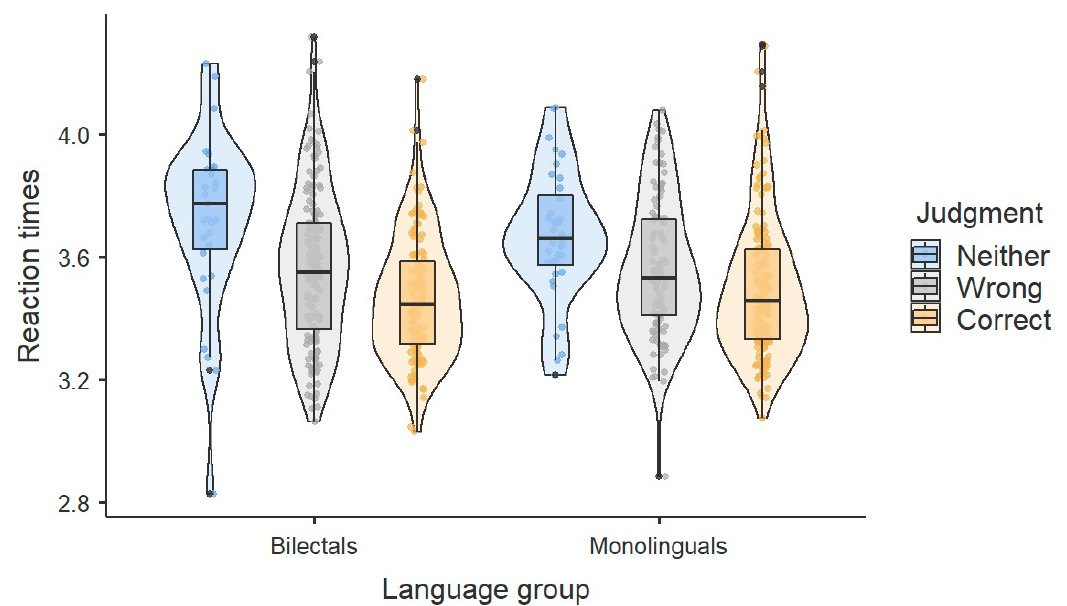
Figure 4. Log-transformed reaction times split for language group and judgment.